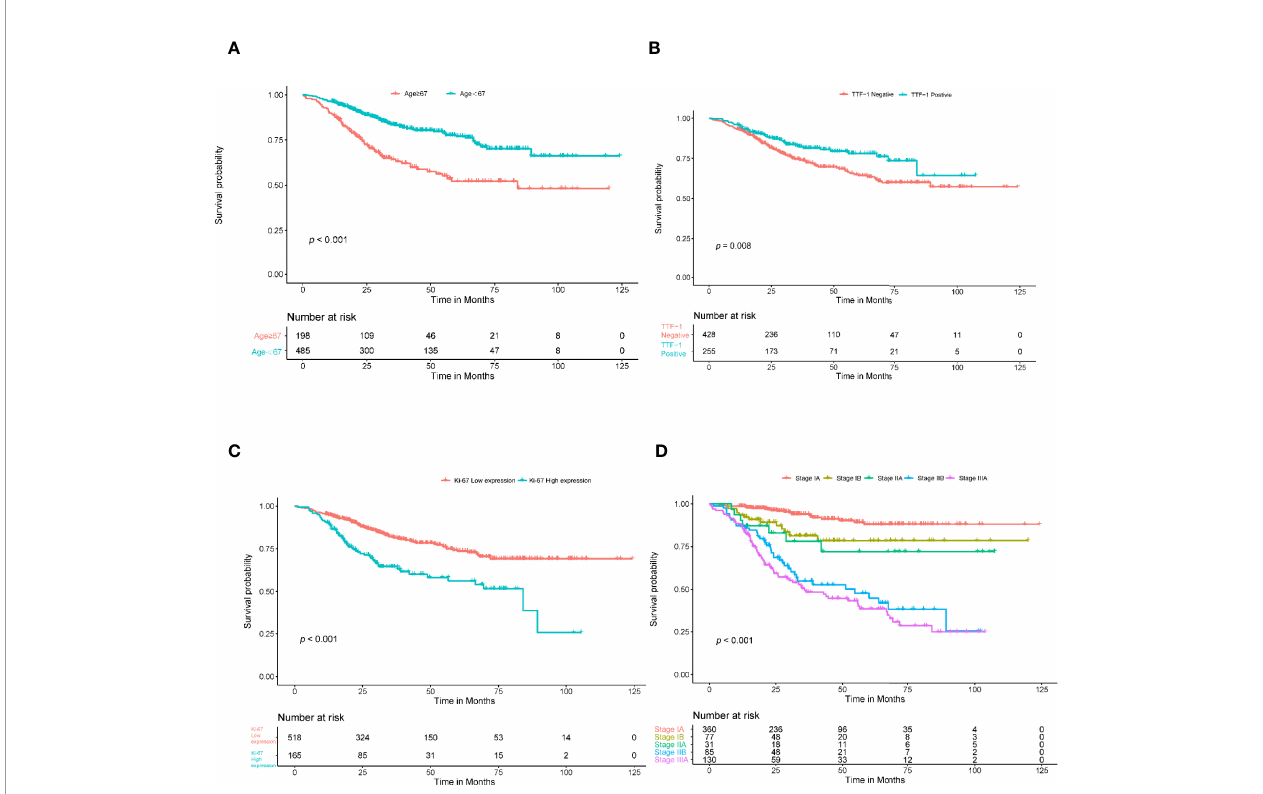
FIGURE 3 | Kaplan-Meier survival analysis for age, TTF-1, Ki-67, and stage. The patients were strati fi ed into high- and low-risk groups based on age (A) ( P <0.001, log-rank test), TTF-1 (B) ( P <0.008, log-rank test), Ki-67 (C) ( P <0.001, log-rank test), and stage (D) ( P <0.001, log-rank test).